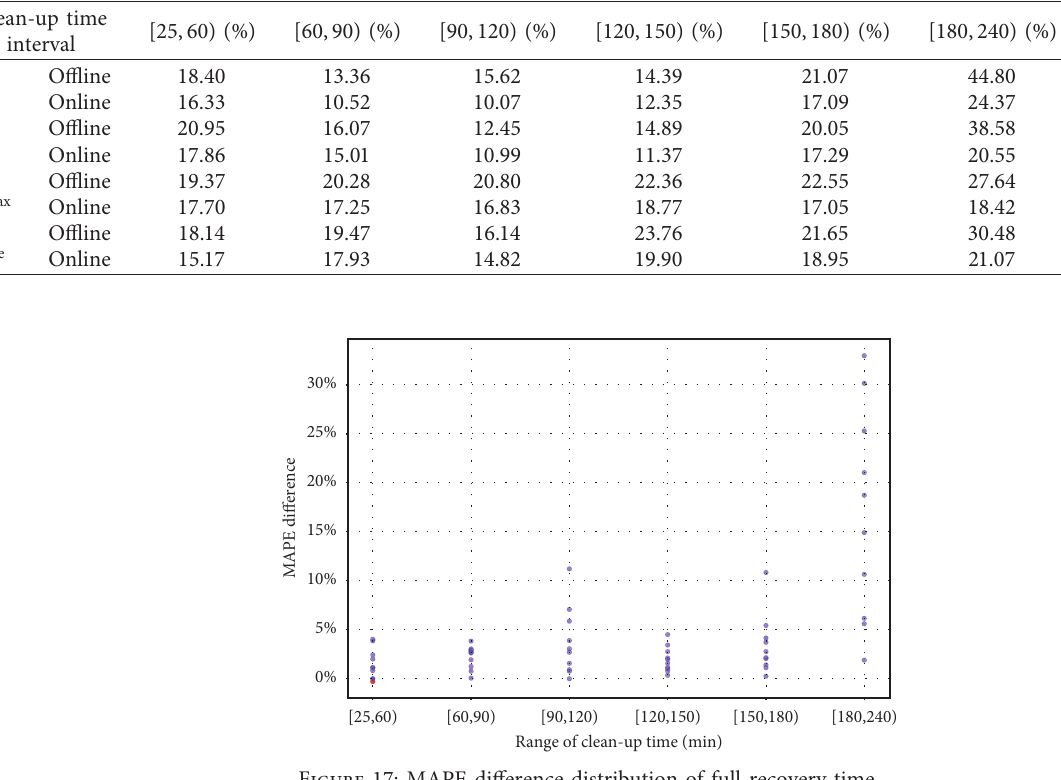
Table 11: Average MAPE in clean-up time intervals before and after adaptation.